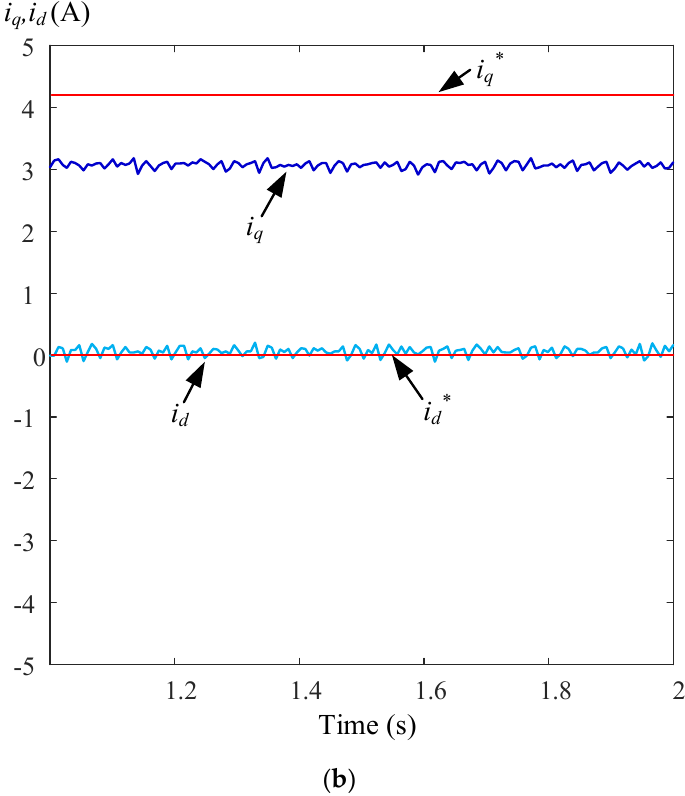
Figure 19. Measured responses at 300 r/min without flux-weakening control. ( a ) speeds, ( b ) currents.